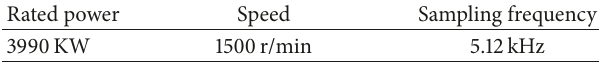
Table 1: The relevant parameters of the test and diesel